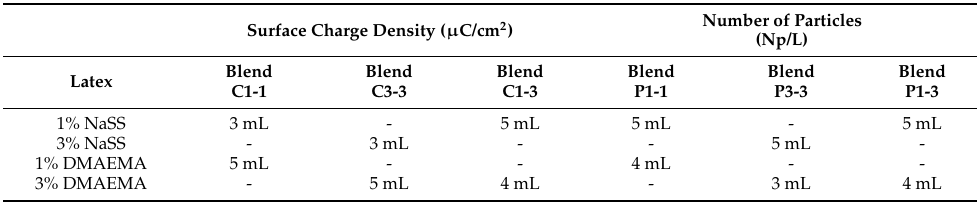
Figure 2. Schematic representation of the blends between NaSS and DMAEMA functionalized latex. Table 1. Receipts for polymer blends preparation.